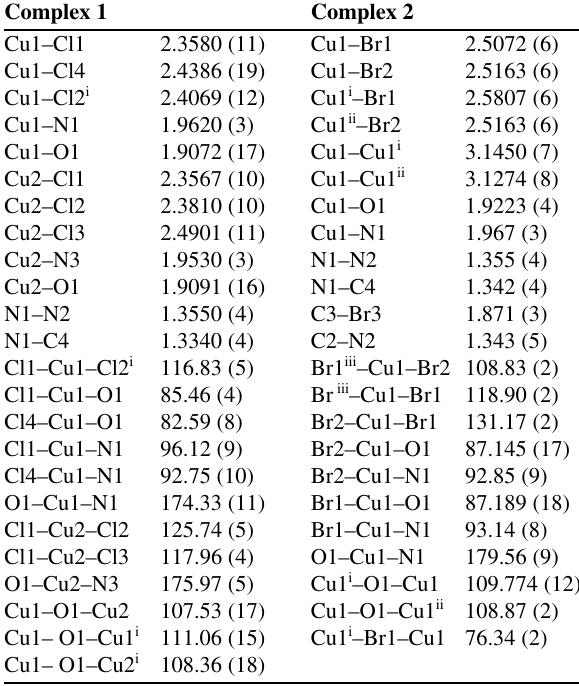
Figure 1. The structure of the [ Cu ster 1 , with labelling of selected atoms, showing only one location of the disordered atom (Cl4). Asterisks indicate atoms generated by symmetry operations. Anisotropic displacement ellipsoids exhibit 30% probability levels. Hydrogen atoms are drawn as circles with small